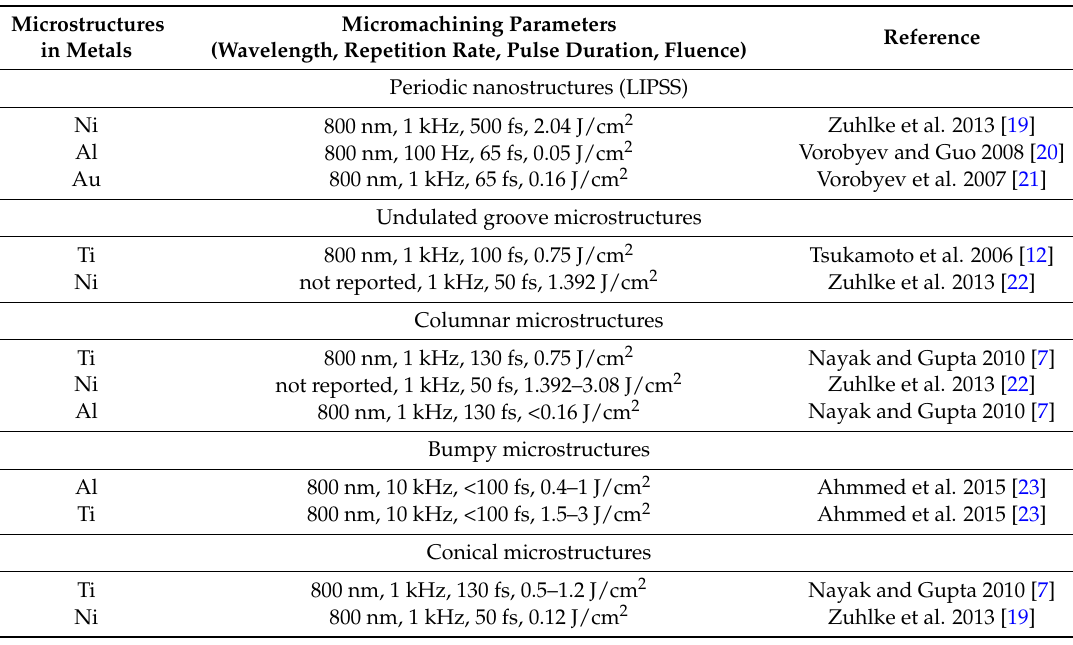
Table 1. Experimental conditions of various microstructures on